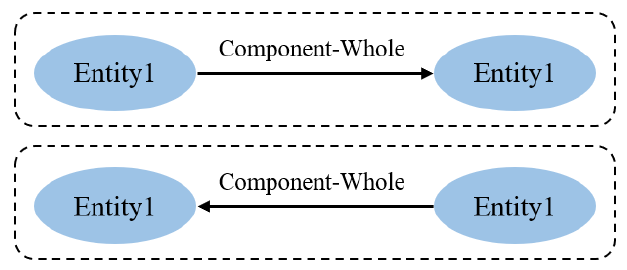
Figure 8. The relation of entity pairs is directional.